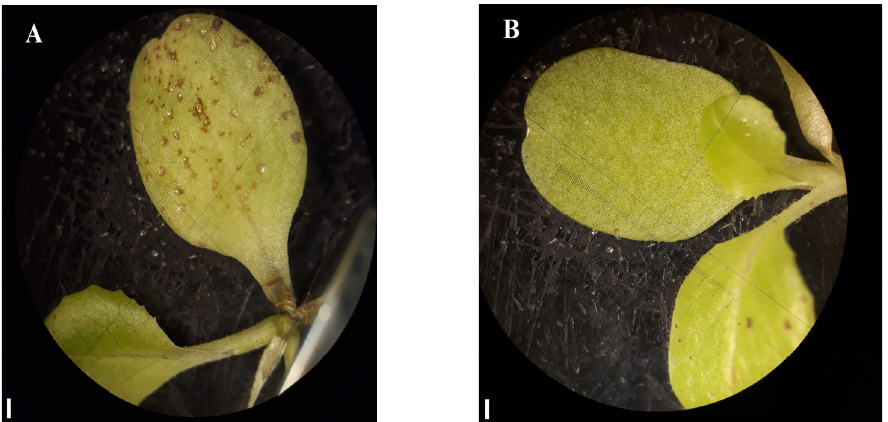
Figure 5. Lactuca sativa leaves at day 7 in the post-emergence bioassay treated with ( A ) aqueous extract (AE) at 4% and ( B ) negative control (distilled water). Note the brown spots on the leaves of ( A ). Bar = 1 mm.